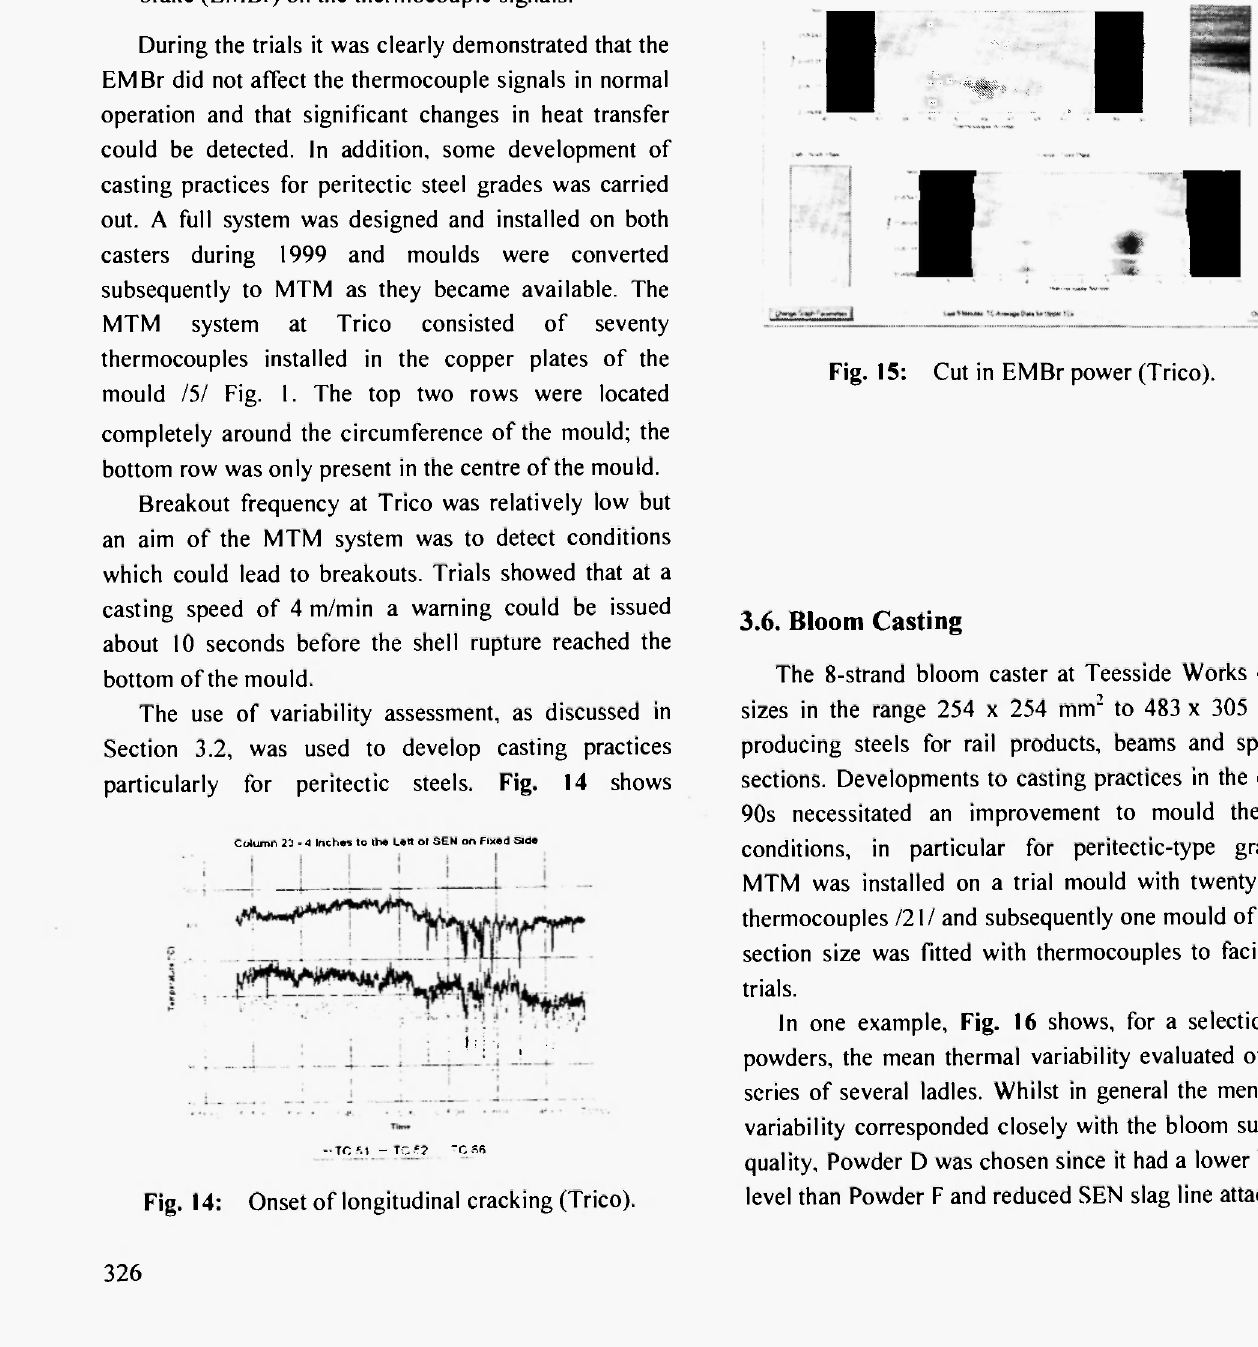
Fig. 14: Onset of longitudinal cracking (Trico).